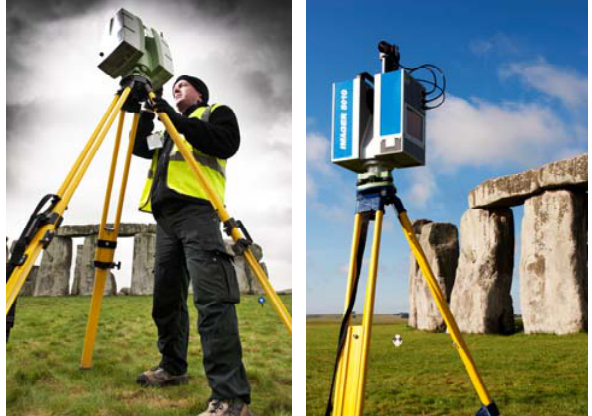
Figure 4 – Laser scanning Stonehenge using the Leica C10 and Z+F 5010 (Images by James Davies © English Heritage)